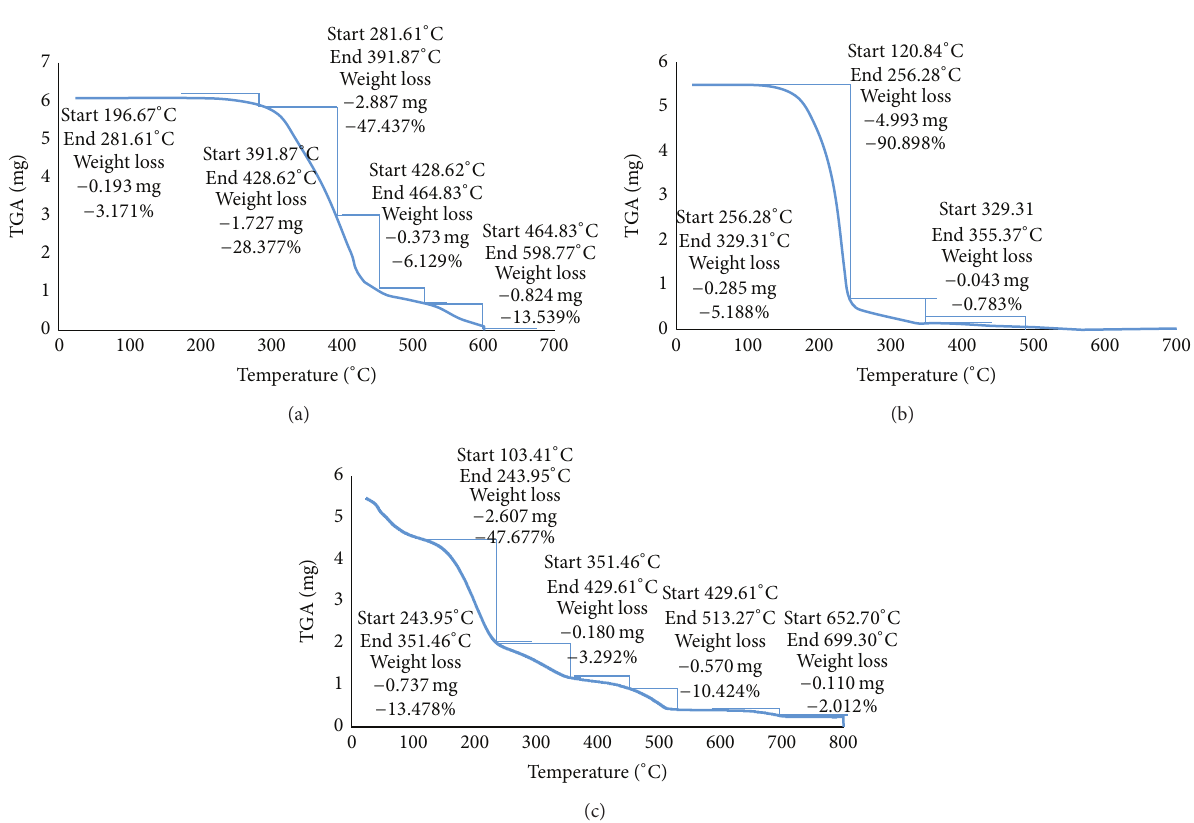
The most characteristic absorption peaks of the waste vegetable oil were indicated in Figure 8(a). The absorption peak appearing at 721 cm −1 is representative of -CH 2 rocking and the other one at 1745 cm −1 is representative of C=O ester stretch. Figure 8(b) showed the produced biodiesel absorption peaks appearing at 1434 cm −1 which is the methyl ester group (CO-O-CH 3 ) and the characterization peak at